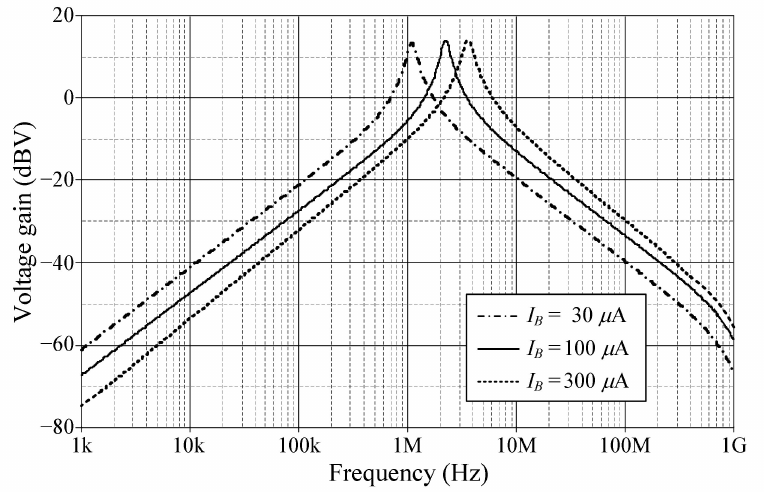
Figure 11. Simulated BP gain responses in VM for variation in f o with Q =